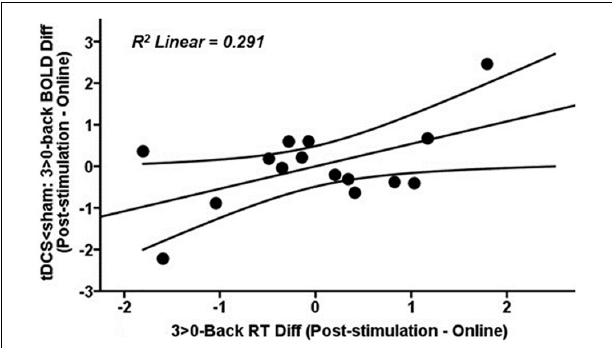
FIGURE 7 | Scatter plot showing the relationship at the highest WM load between tDCS-induced changes in BOLD signal post-stimulation when compared to online within the fMRI cluster where tDCS showed less activity than sham after stimulation ( Figure 6A , blue-light blue fMRI cluster) and RT post-stimulation as compared to online. Data are presented with z scores. tDCS, transcranial direct current stimulation; BOLD, blood oxygen level dependent; Diff, difference; RT, reaction